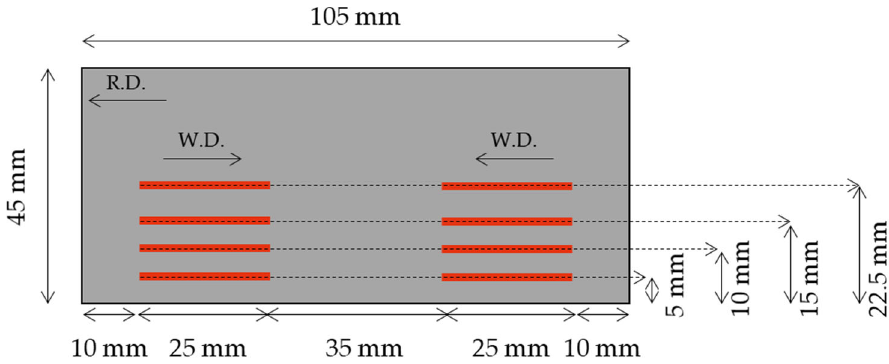
Figure 6. Edge distance positions for evaluation of the most susceptible position to cold cracking.